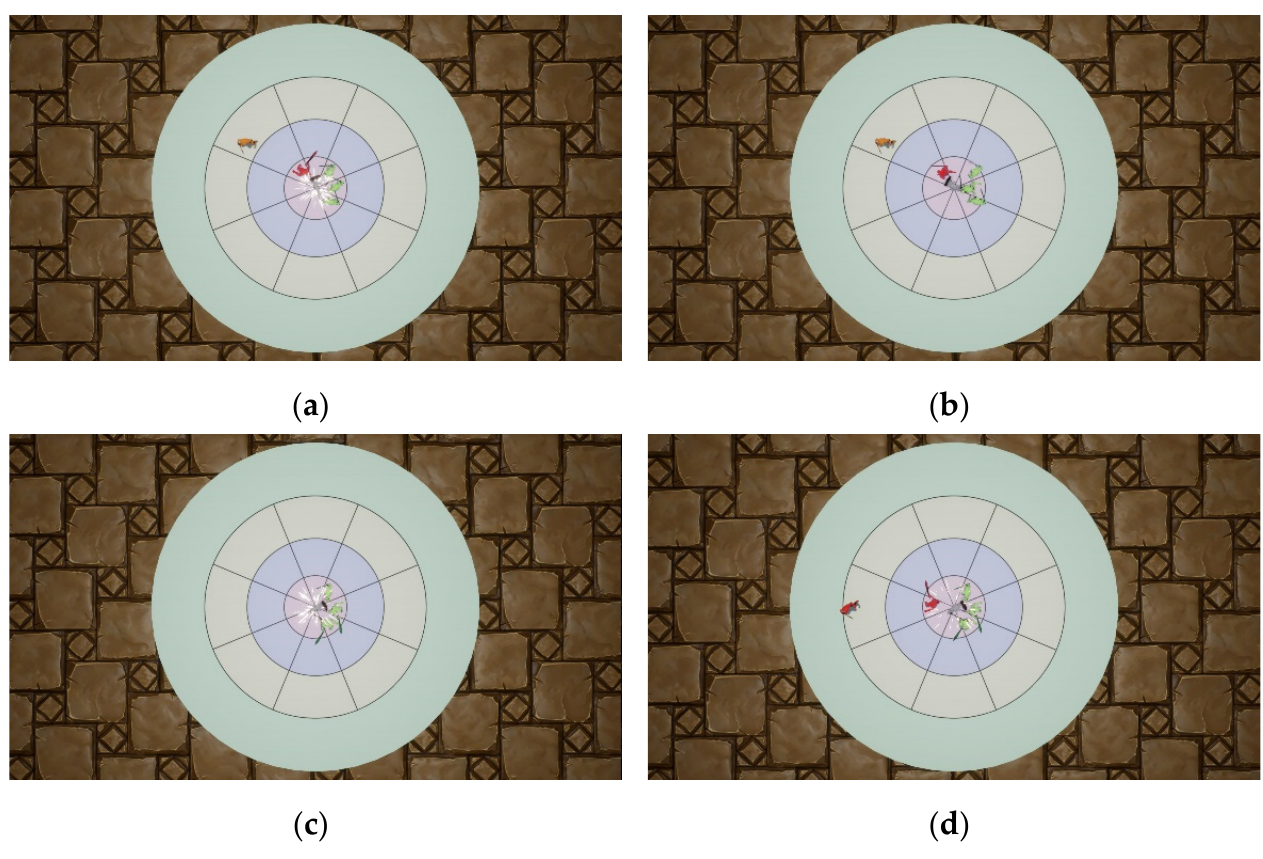
Figure 10. Allocation logic tests of IBAI. ( a ) The first combat scene; ( b ) The second combat scene; ( c ) The third combat scene; ( d ) The fourth combat scene.